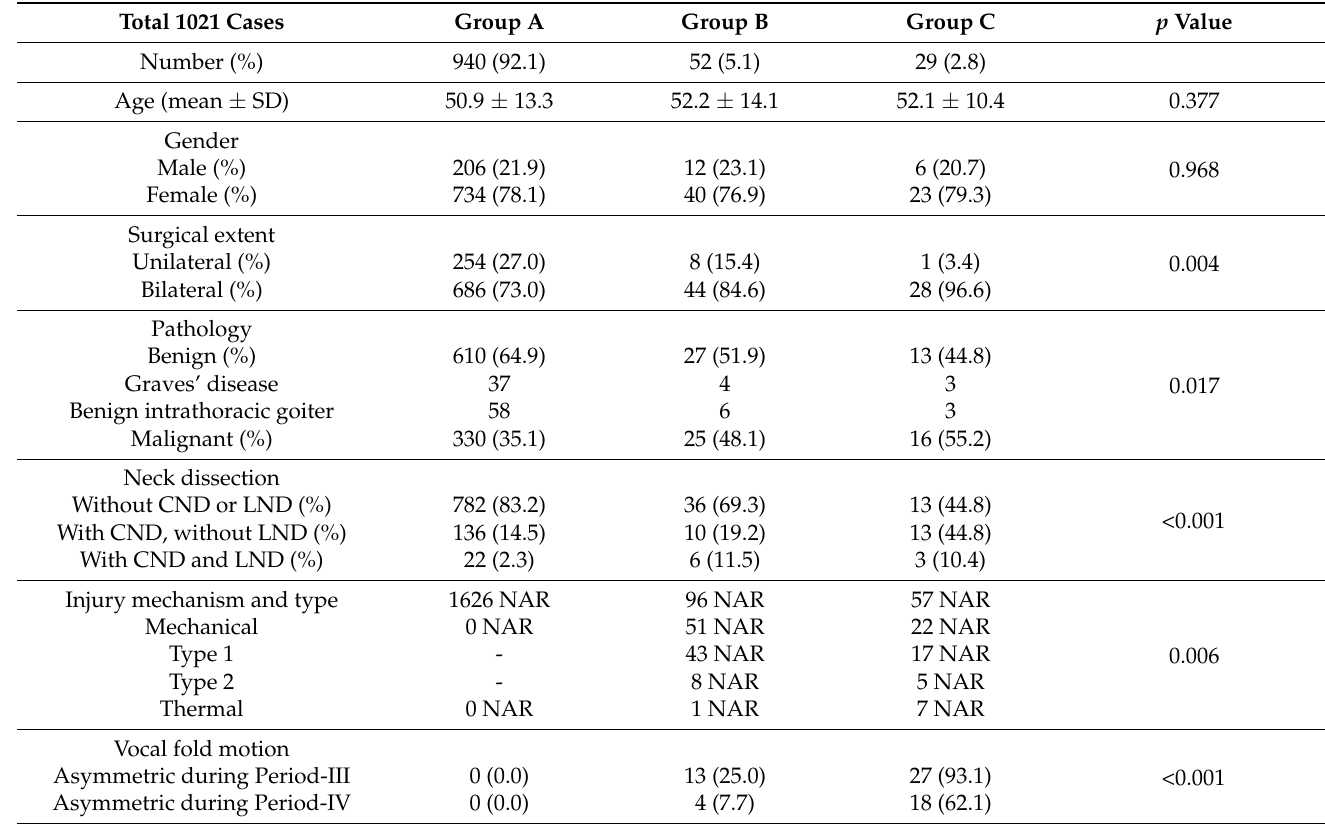
Table 1. Demographic characteristic of patients who received monitored